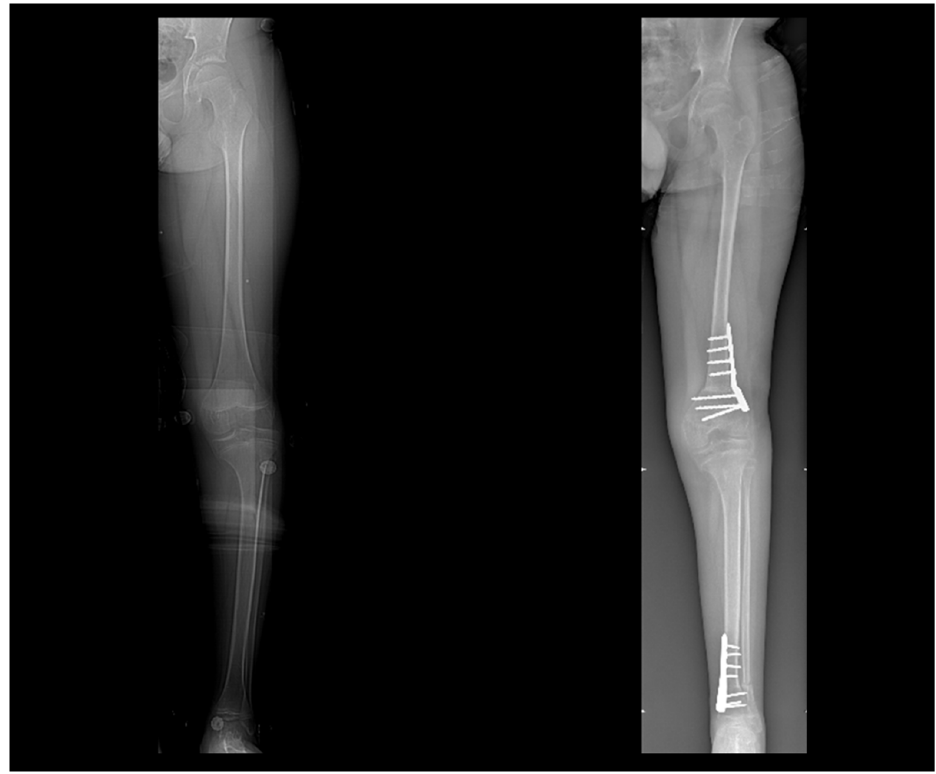
Figure 13. Preoperative and postoperative radiographs.